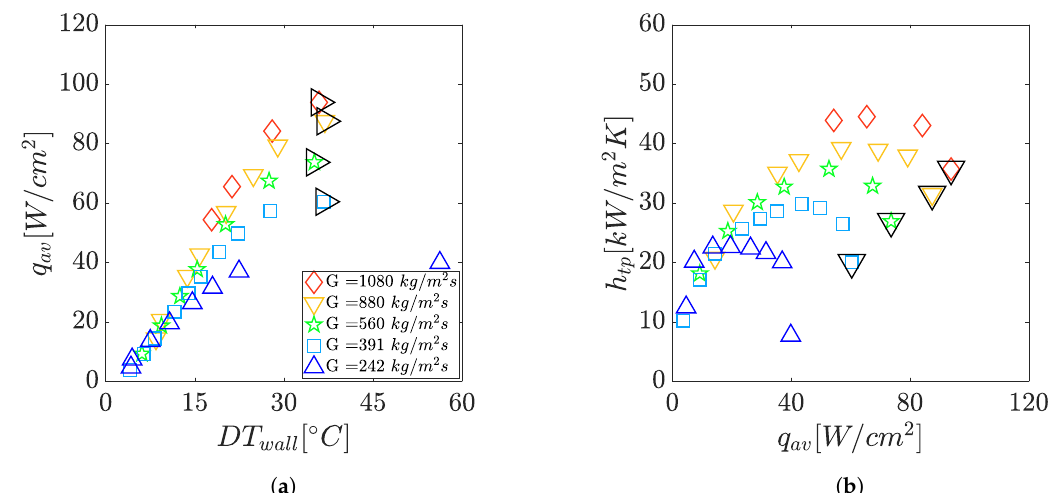
Figure 11. Boiling curves ( a ) and channel average heat transfer coefficient ( b ) in Geometry C for a nominal saturation ◦ temperature of 30 C at the outlet of the channels.